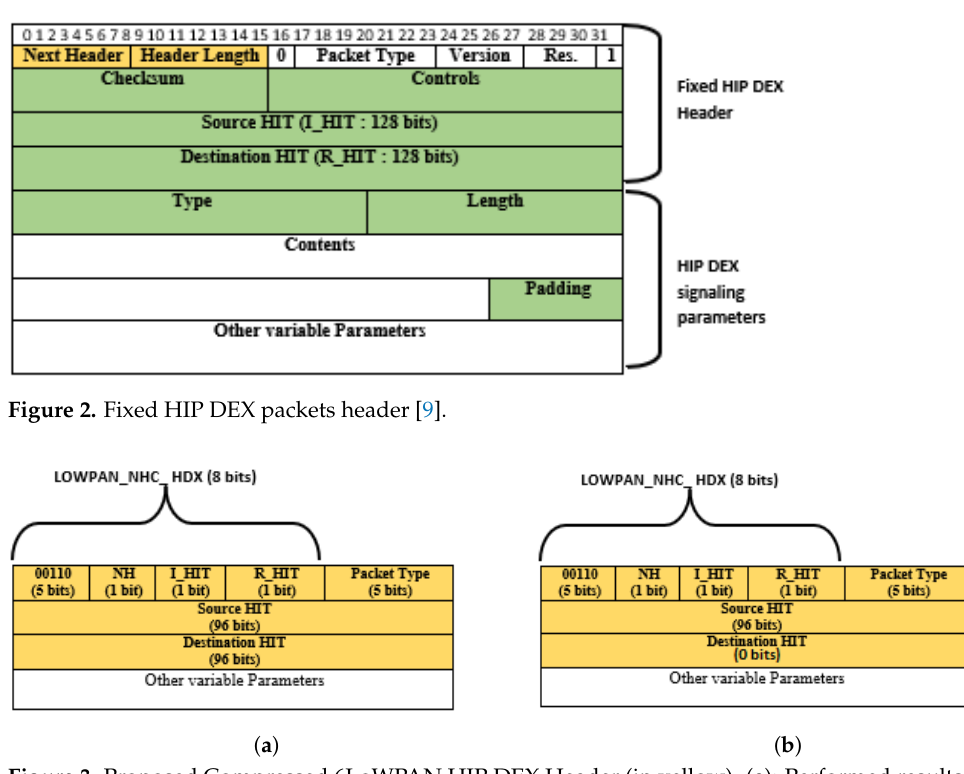
Figure 3. Proposed Compressed 6LoWPAN HIP DEX Header (in yellow). ( a ): Performed results in the conference paper [9]. ( b ): Results obtained with LC-DEX.